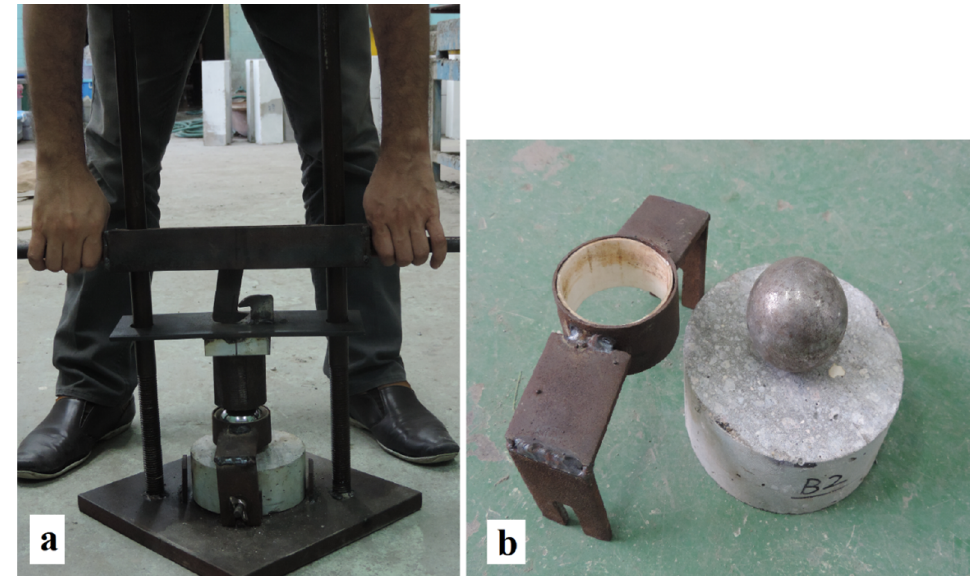
Figure 4. ( a ) Impact resistance test device and ( b ) steel ball and disk sample.